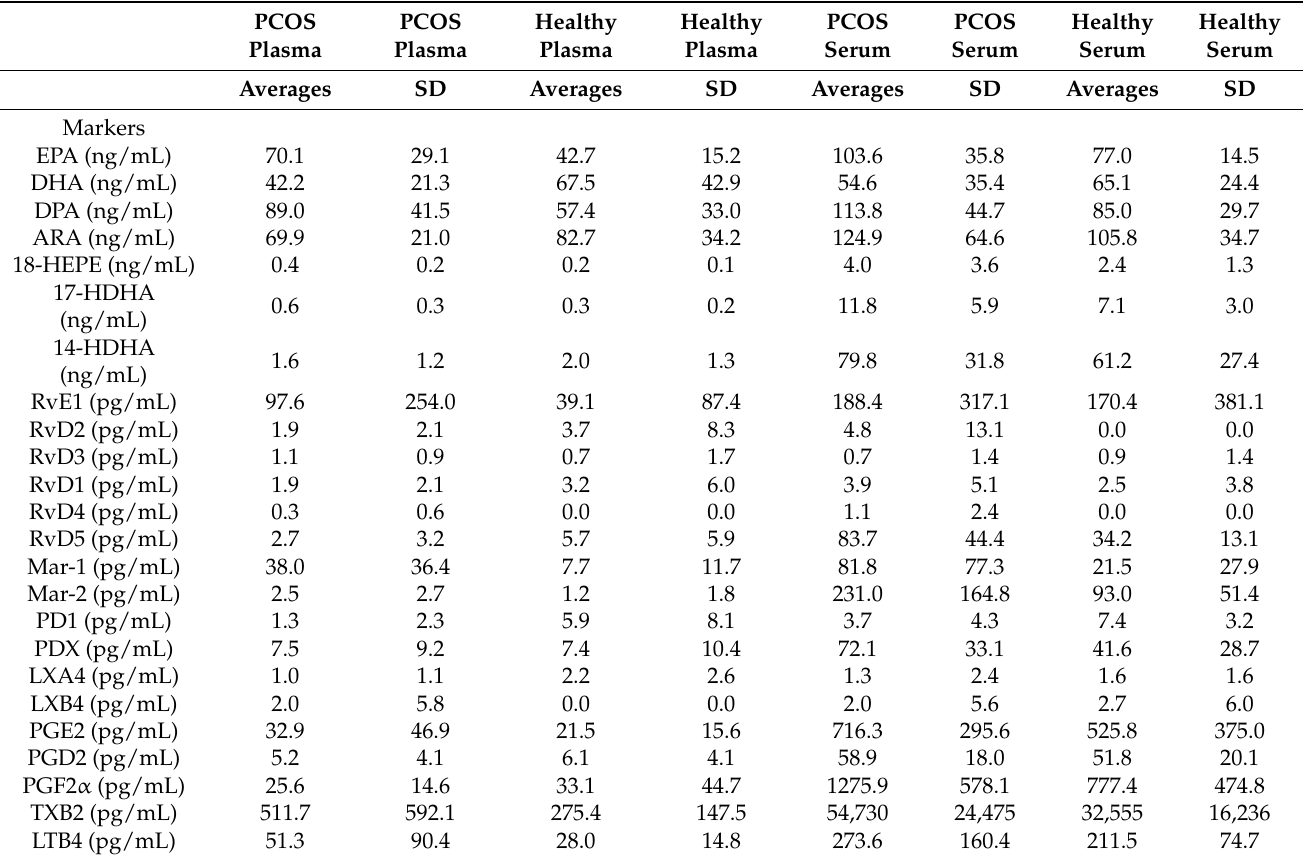
Table 2. Values in tabular